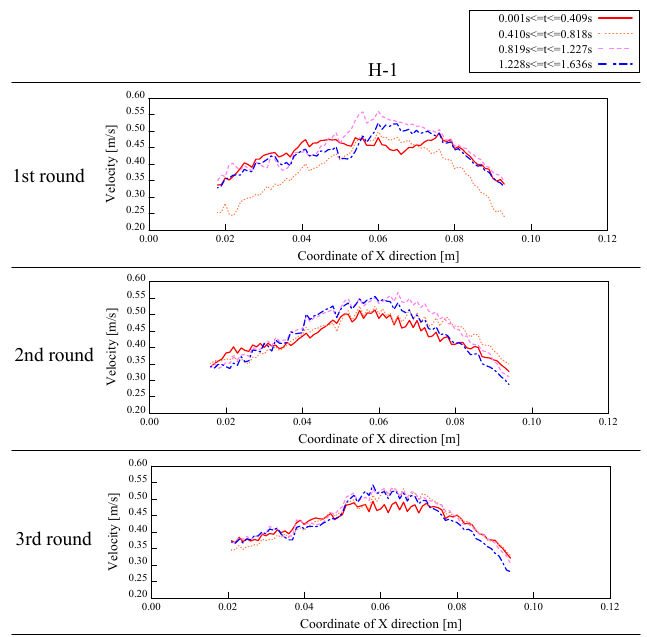
Figure 11. Relationship of the flow velocities in each cross section by combining the horizontal and vertical flow velocities for every 409 frames (0.409 s) of four 1636 frames from H-1.